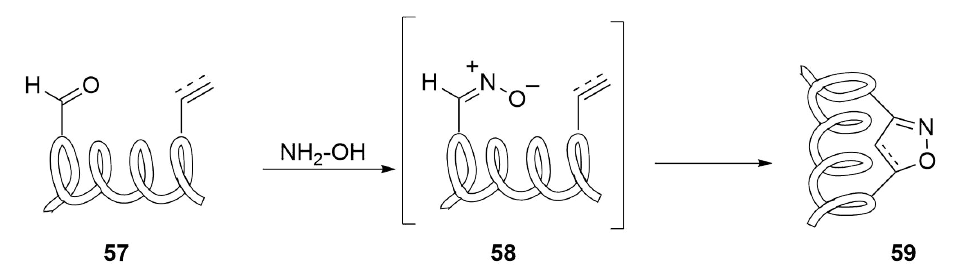
Scheme 25. Example of Nitrile Oxide Stapling